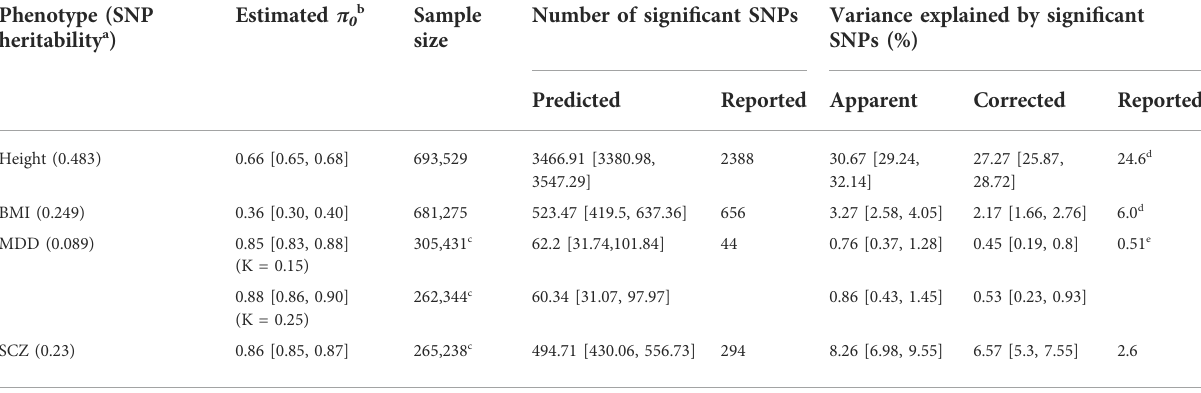
TABLE4Predictedversusreportednumbersofindependentsigni fi cantSNPsandvarianceexplainedbytheseSNPswith95%probabilityintervals(PIs) based on the range of estimated π 0 for height, body mass index (BMI), major depressive disorder (MDD), and schizophrenia